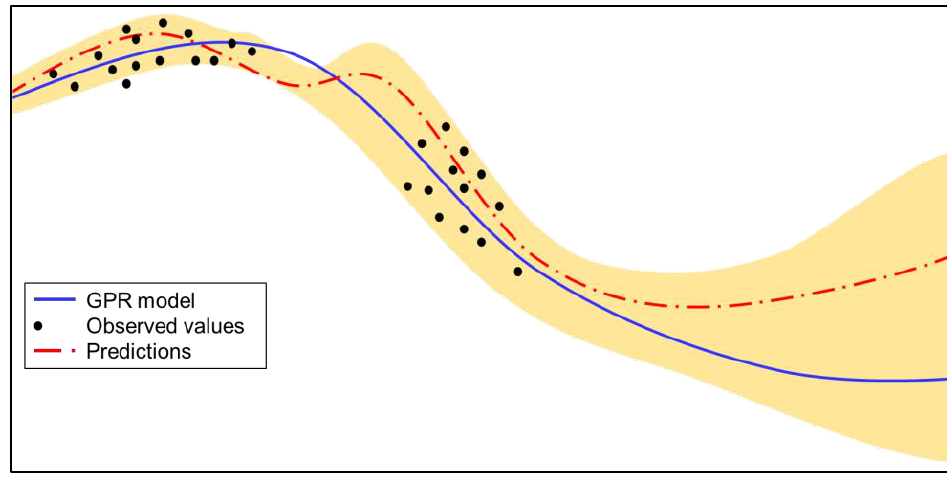
Figure 2. GPR example.